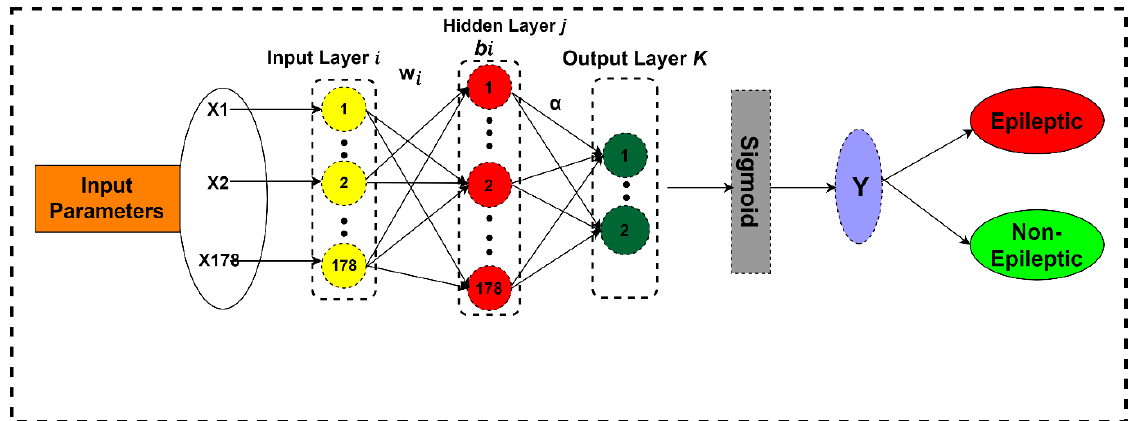
Figure 4. Extreme Learning Machine.